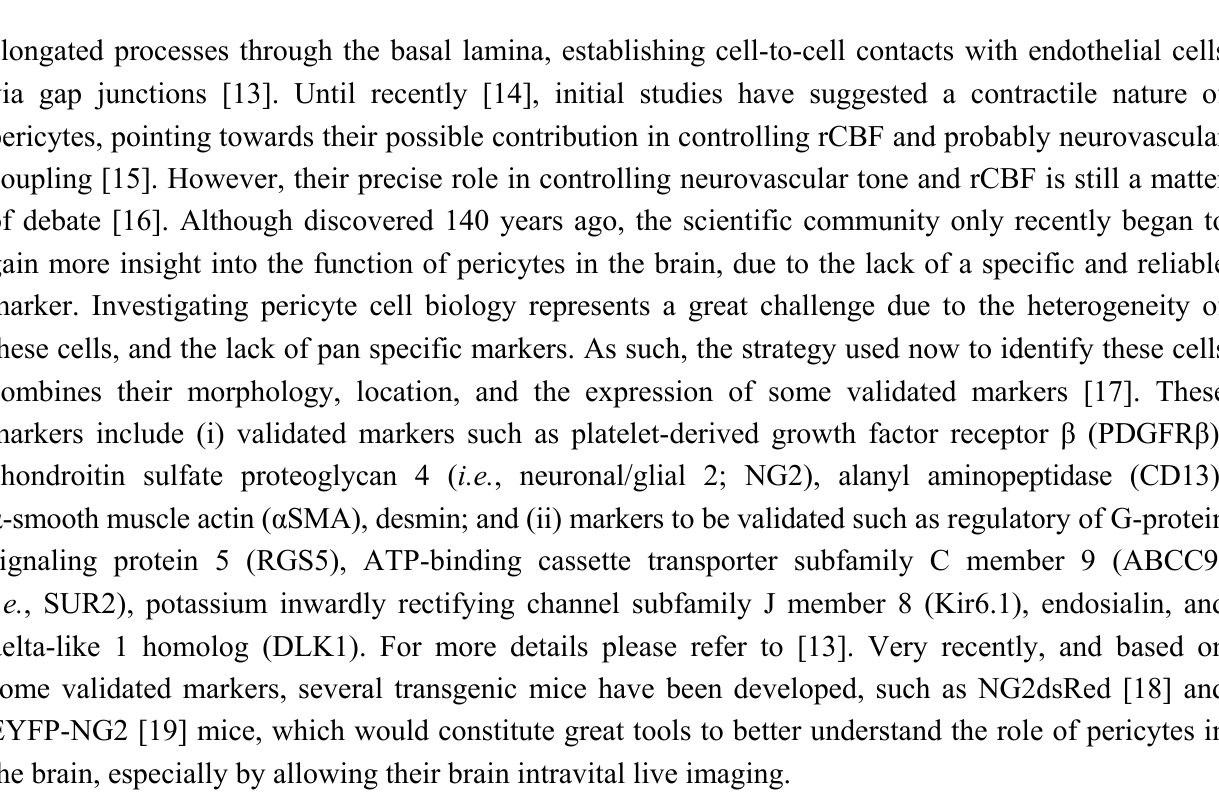
Figure 1. The role of pericytes at the neurovascular unit (NVU) in the healthy brain. The NVU is constituted by specialized endothelial cells, which form the blood-brain barrier (BBB), that actively interact with the basal lamina, pericytes, astrocyte-endfeet, microglia and neurons. The pericytes play an important role in maintaining NVU physiological functions by controlling tight junction (TJ) protein expression and BBB induction, microvascular stability and microvessel diameter. Pericytes might act as pluripotent cells and might have immune function at the